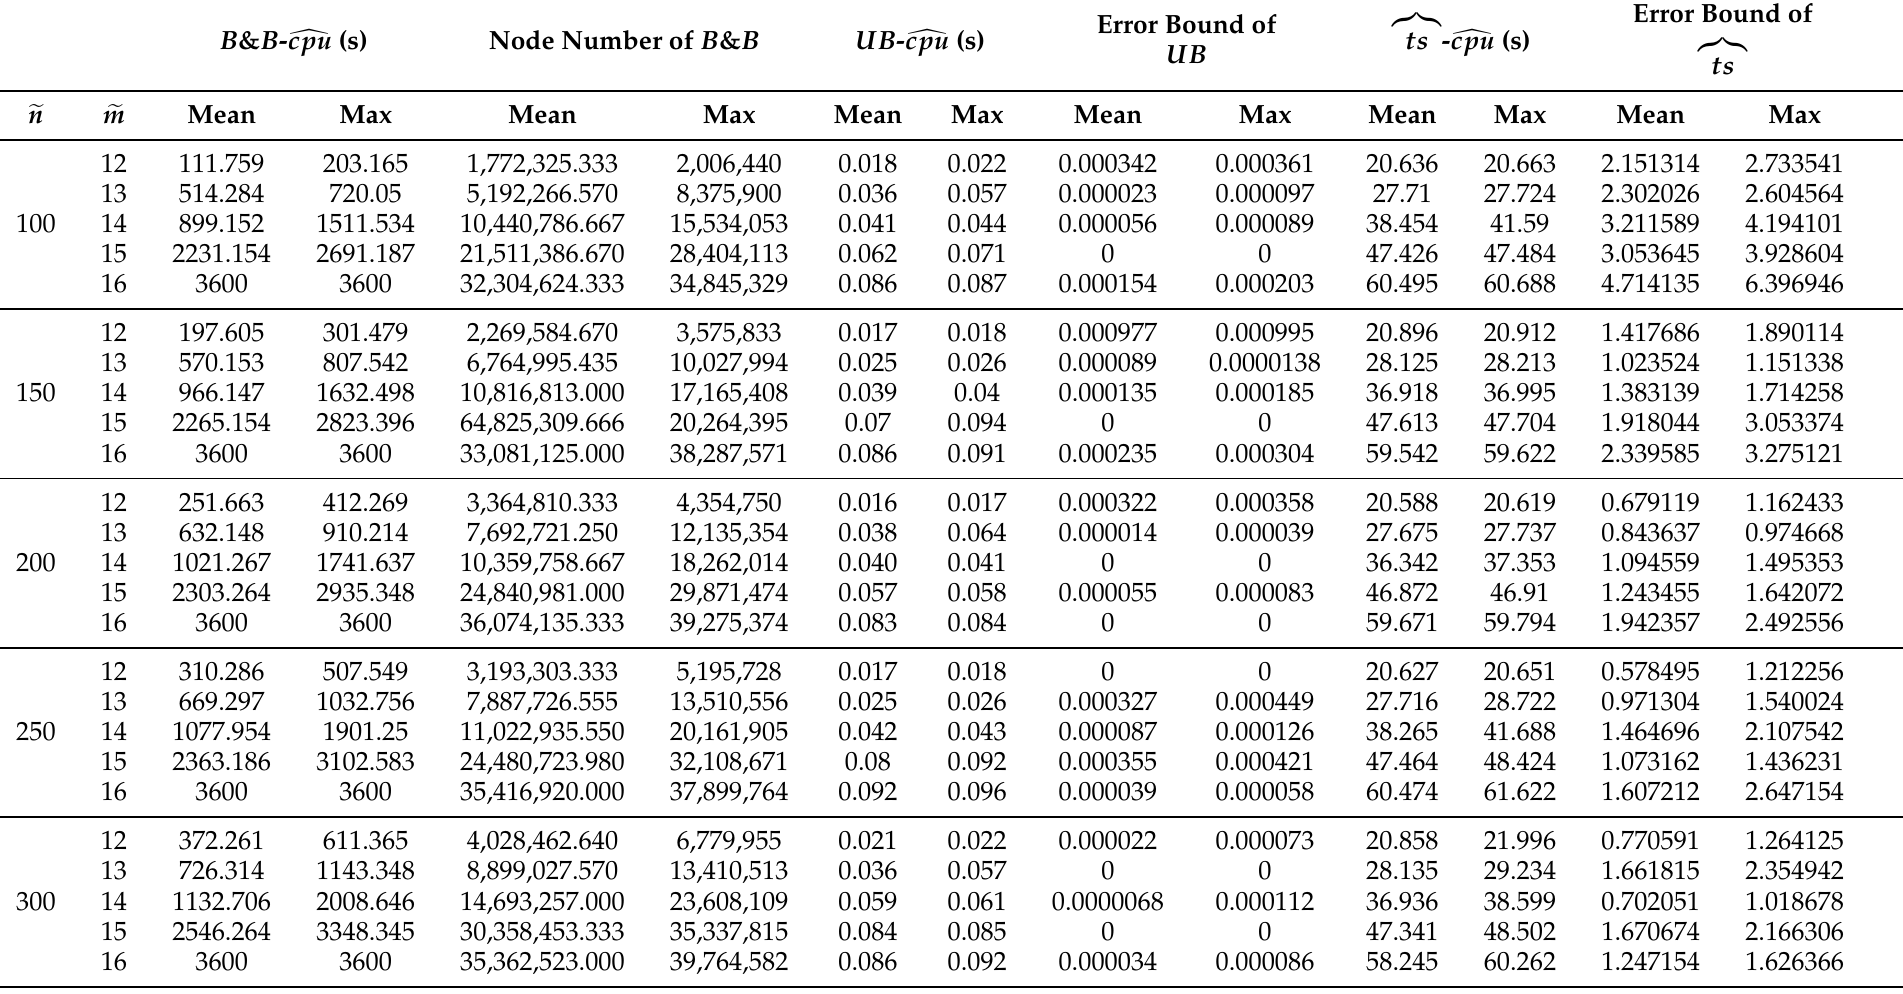
Table 3. Results of algorithms for θ , µ ∼ ( 0.5,1 )